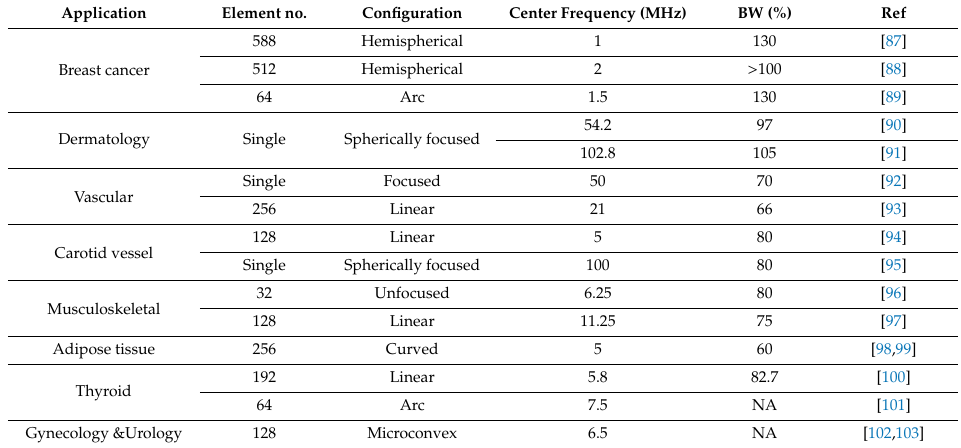
Table 2. Di ff erent configurations of piezoelectric ultrasound transducer arrays that are used in clinical applications of photoacoustic imaging. BW: